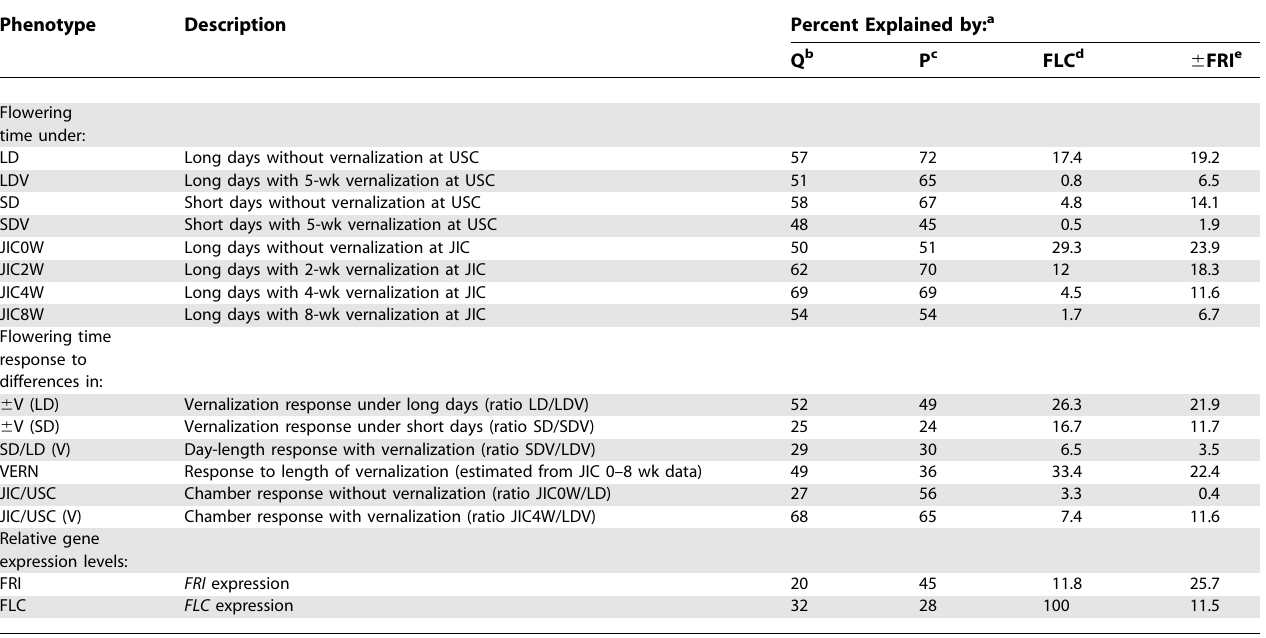
Table 1. Summary of Phenotypes Used